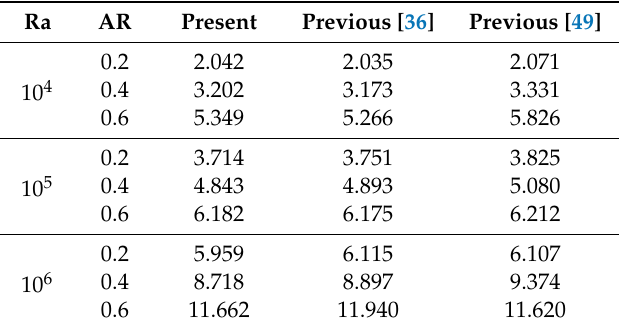
Figure 3. Isotherms (left side) and streamlines (right side) patterns inside the square enclosure when Rayleigh number is, Ra = 10 6 , and aspect ratio, AR = 0.2. Table 1. The details of the surface average Nusselt number, Nu , on the inner cylinder at different combinations of Ra and AR .